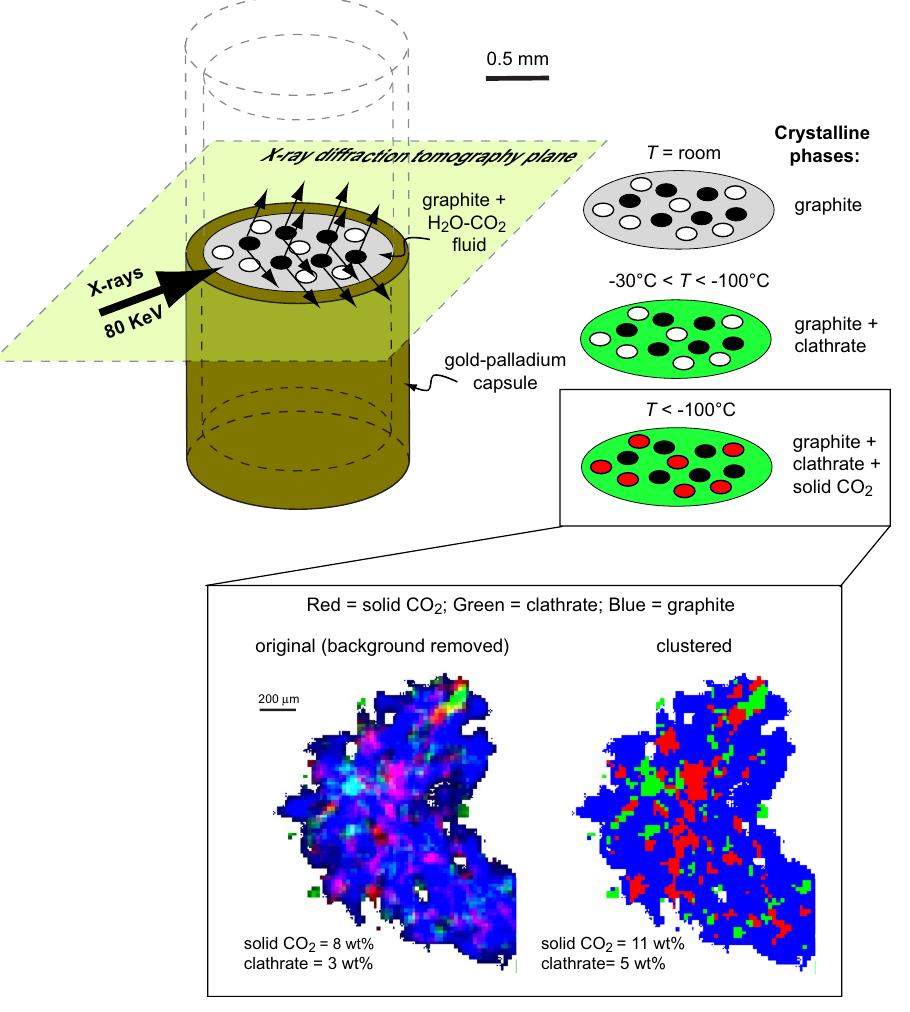
Figure 3. Schematic representation of X-ray diffraction microtomography of the experimental capsule (left) and the phase transitions observed in the H 2 O–CO 2 fluid upon cooling (right). The inset shows the microtomogram collected at − 180 °C, i.e., when the fluid is converted into solid crystalline clathrate and CO 2(s) : red, green and blue channels have been attributed to the characteristic peaks of solid CO 2 , clathrate and graphite, respectively, and combined into an RGB image after background removal (left) or clustering (right); the estimated mass percentages of solid CO 2 and clathrate are